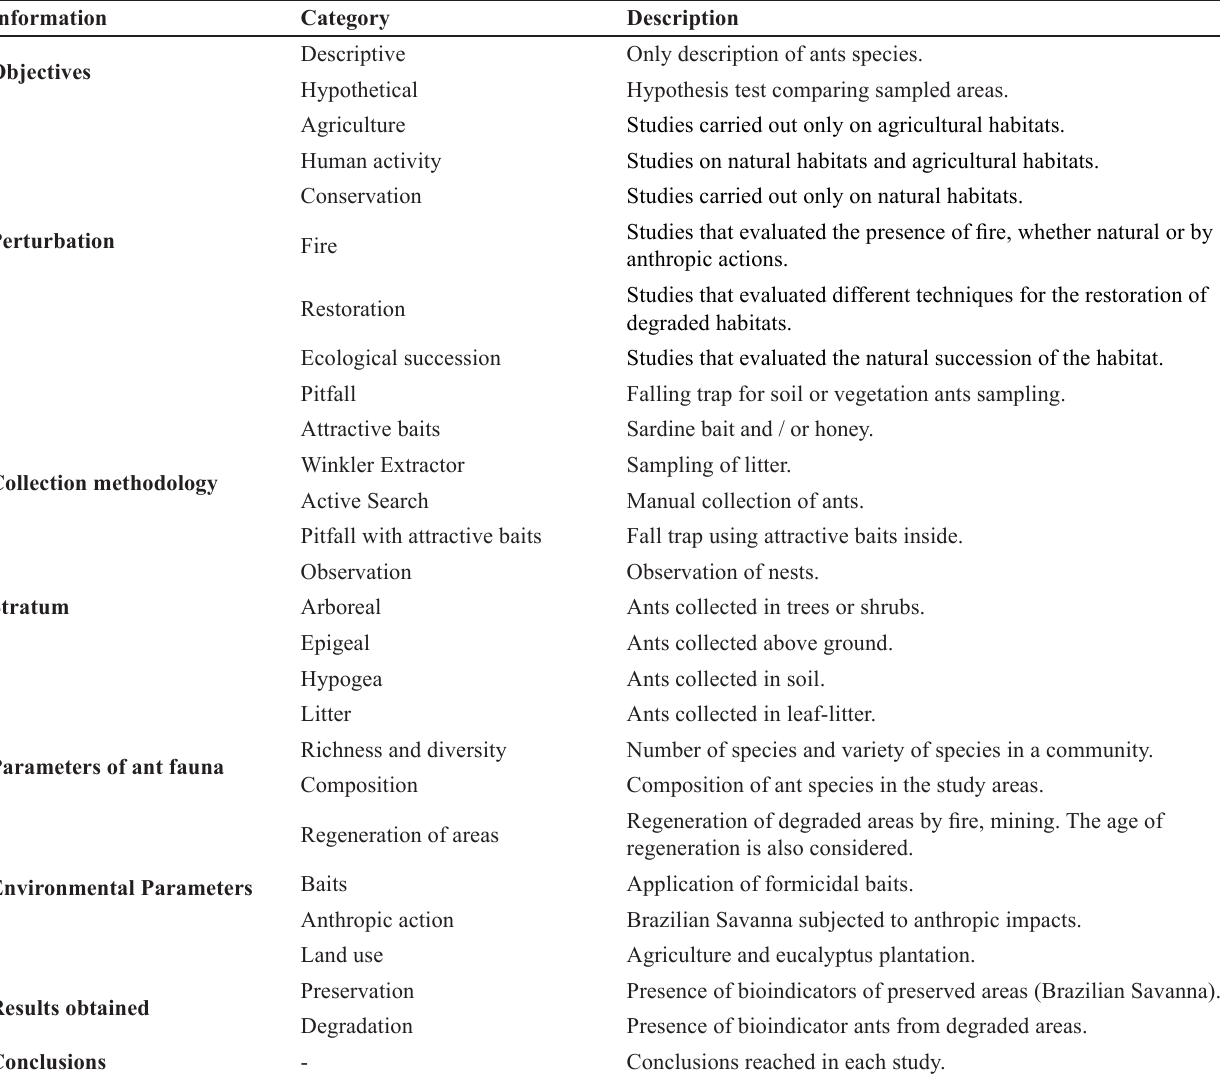
Table 1. Description of the information evaluated, categories of analysis and description of disturbances of the papers